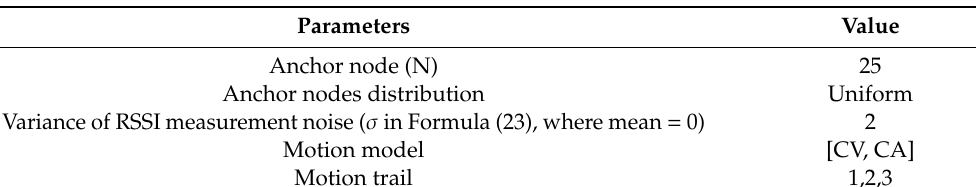
Table 3. Parameter settings.